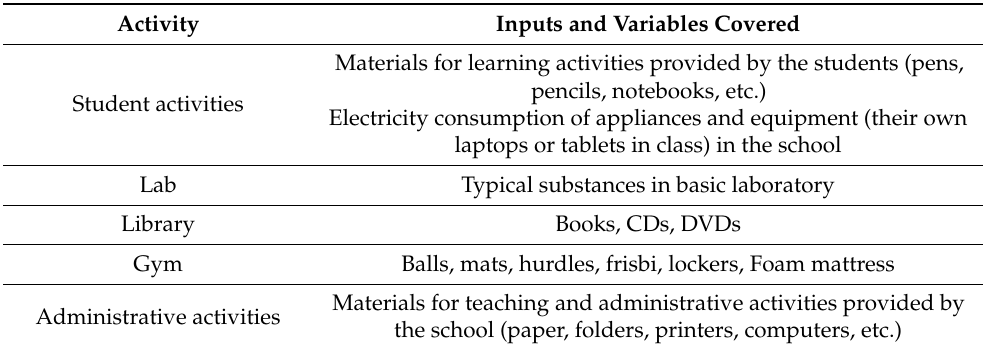
Table 3. Activities included in Subsystem 2 (Teaching and learning,